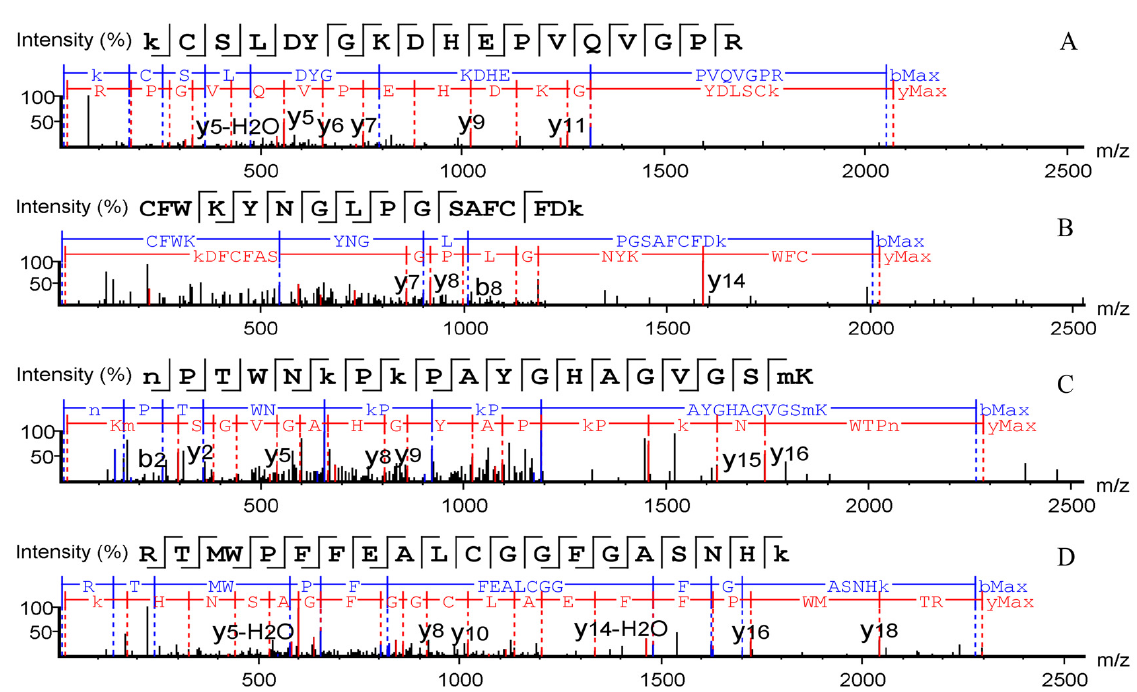
Figure 4. The sequence of four donkey-specific marker peptides identified by de novo sequencing (in PEAKS Studio software using a tolerance of precursor and fragment mass of 0.1 Da), including ( A ) DM1, KCSLDYGKDHEPVQVGPR; ( B ) DM2, CFWKYNGLPGSAFCFDK; ( C ) DM3, NPTWNKPKPAYGHAGVGSMK; ( D ) DM4, RTMWPFFEALCGGFGASNHK.